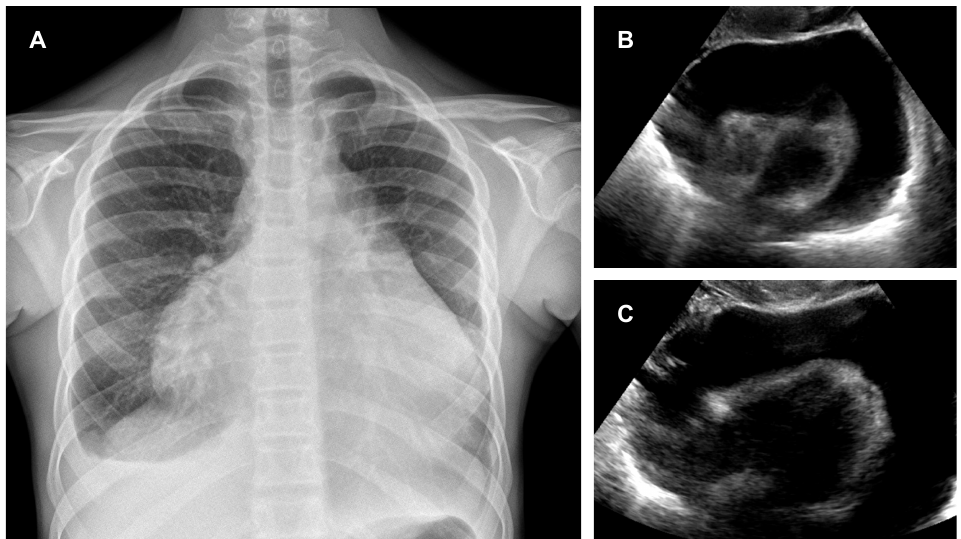
Figure 1. Massive pericardial effusion in a 14 ‐ year ‐ old girl. A chest X ‐ ray shows an abnormal cardiac silhouette with an increased cardiothoracic ratio (0.8) and bilateral pleural effusion ( A ). Echocardiography shows massive pericardial effusion with “swinging heart” signs ( B , C ).